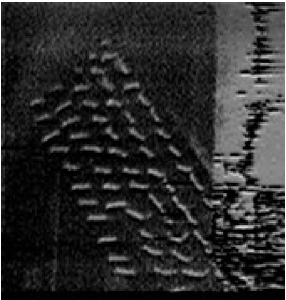
Figure 6: Discharge velocity profile and flow visualization correla-